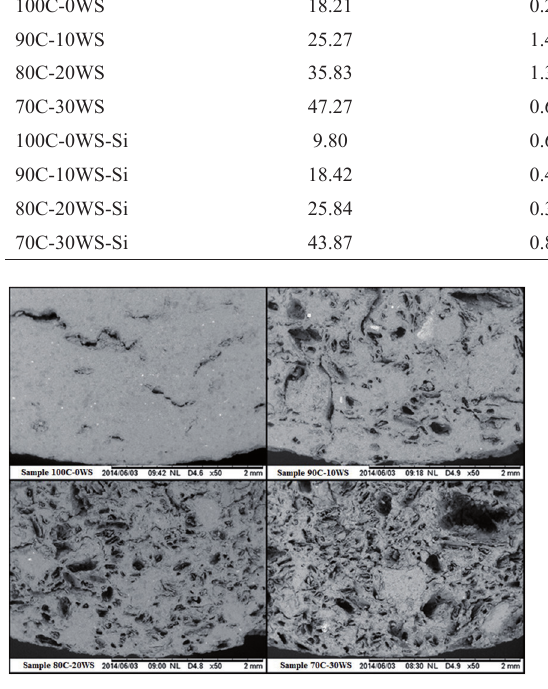
Figure 3: Water absorption and apparent porosity of calcined aggregates made with clay and wood sawdust, fired out at 900ºC